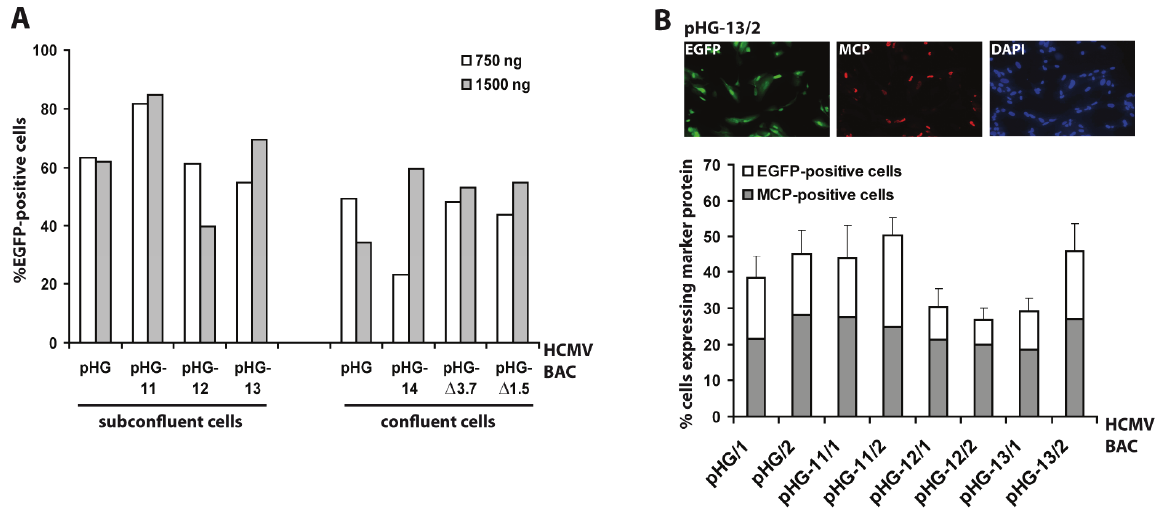
Figure 2. Evaluation of adenofection conditions and late protein expression in adenofected cells. ( A ) Subconfluent or confluent RPE-1 cells were transfected with 750 or 1,500 ng of the HCMV BACs indicated. On day 1 post transfection the percentage of EGFP-expressing cells was determined by flow cytometry. Each bar represents the mean value of two transfections; ( B ) RPE-1 cells transfected with the HCMV BACs indicated were stained on day 4 post transfection with DAPI and an antibody against the major capsid protein (MCP). Ten random images were taken per setting, and the percentages of EGFP-positive cells (white bars) and MCP-expressing cells (grey bars) were determined. The index numbers following the names of the BACs (/1 and /2) indicate that 750 and 1,500 ng of BAC DNA were used for adenofection,